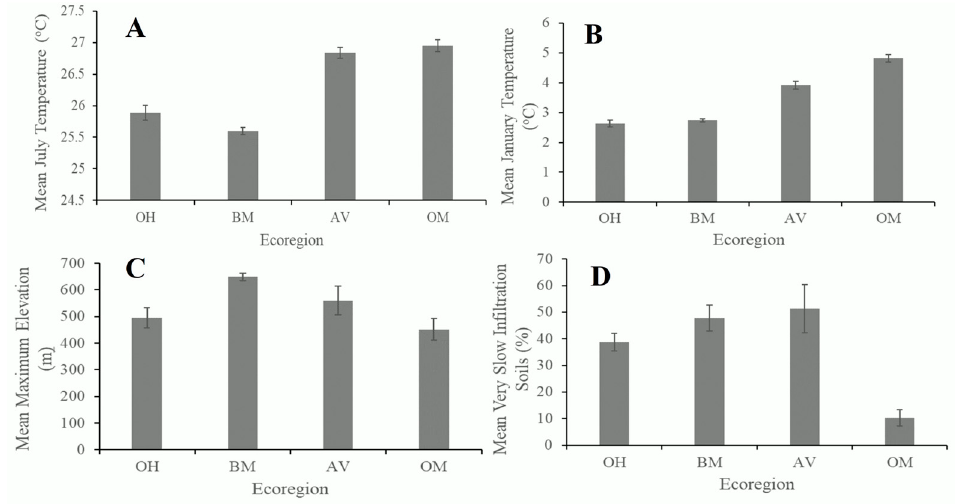
Figure 5. The mean + 1SE of July ( A ) and January ( B ) stream temperatures during our study period and of the maximum elevation ( C ) and percentage of very slow infiltration soils ( D ) in study reach catchments grouped by ecoregions. Ecoregions move from north (left) to south (right). OH = Ozark Highlands, BM = Boston Mountains, AV= Arkansas Valley, OM = Ouachita Mountains.